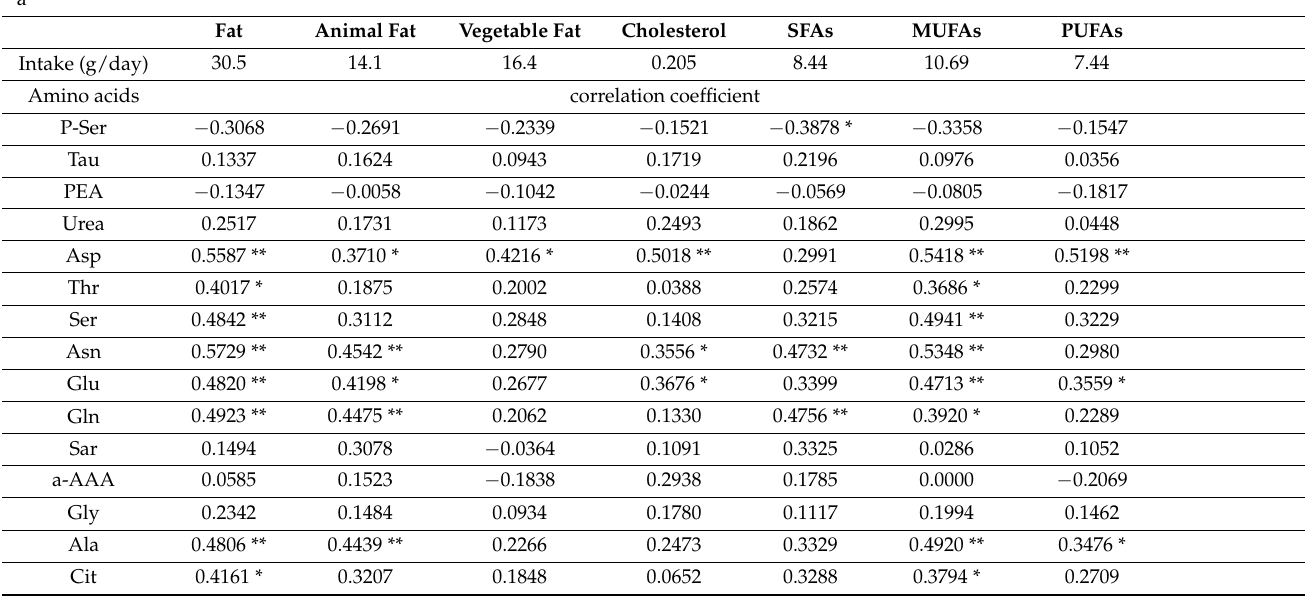
Table 3. Spearman rank correlation coefficients between lipid species in the maternal diet and amino acid concentrations in the amniotic